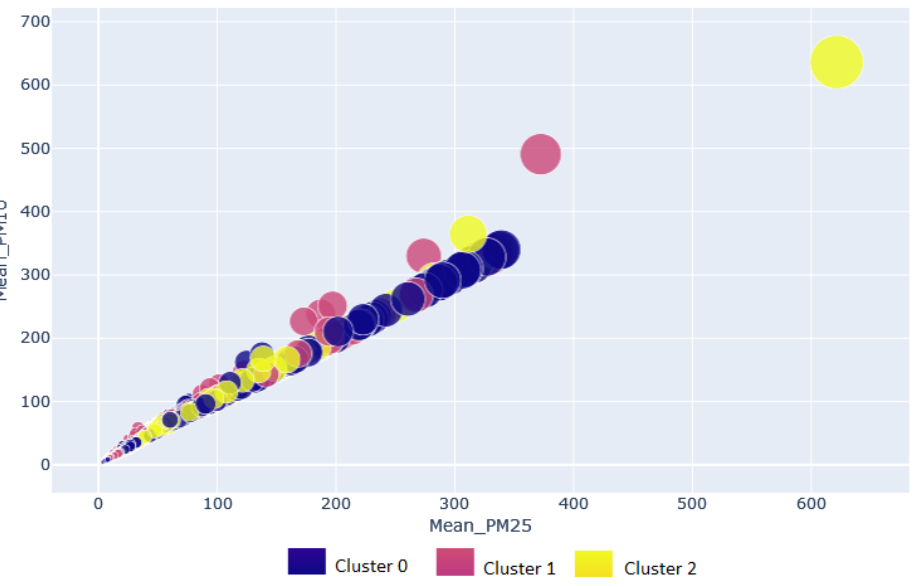
Figure 7. Clustering plot for indoor/outdoor pollution